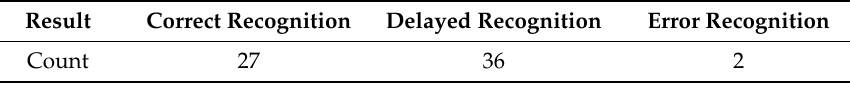
Table 2. The recognition result of the boundaries between continuous actions.